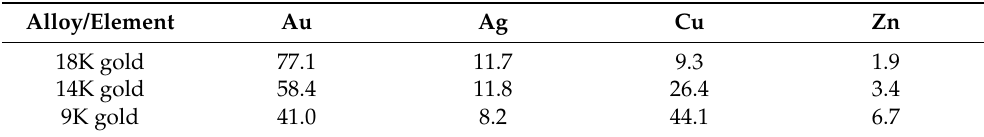
Table 1. Composition of gold alloys (wt.%) by SEM-EDX. Alloy/Element